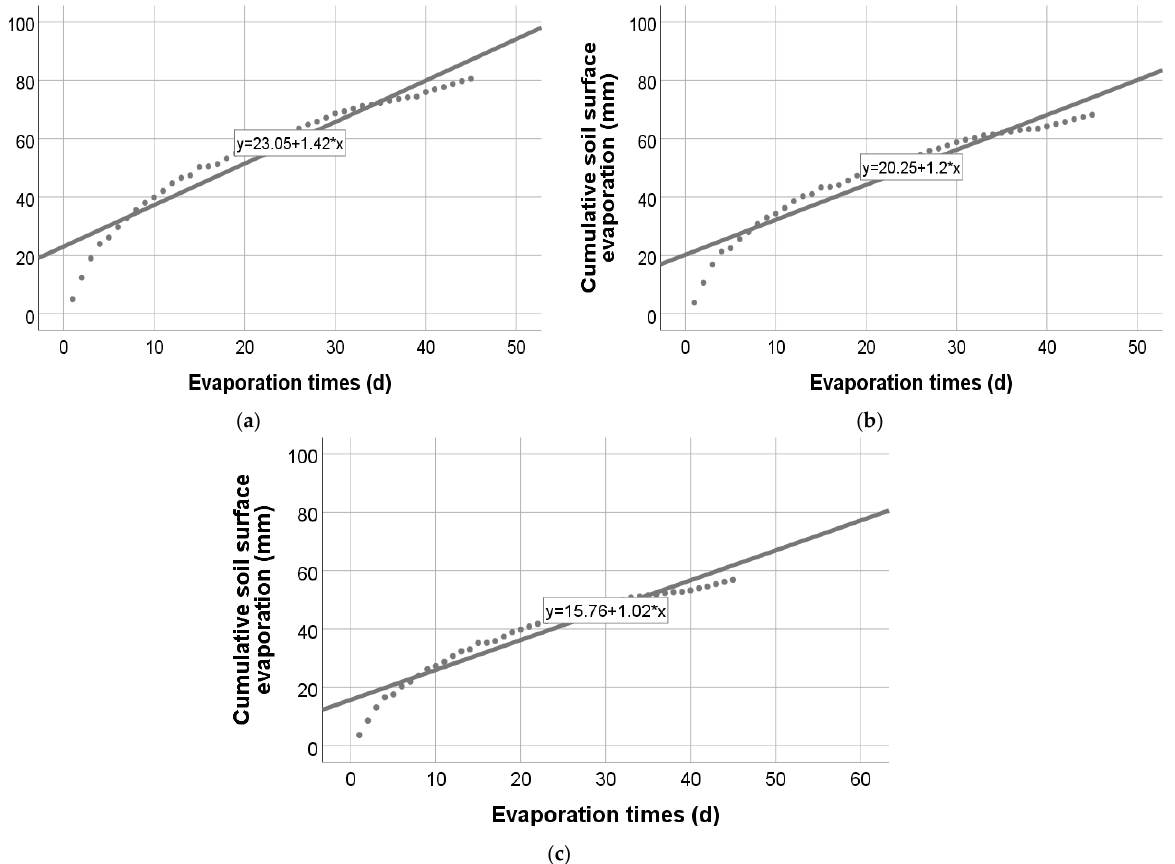
Figure 5. Cumulative soil surface evaporation and evaporation time under three treatments basis on the fitting equation in the ( a ) open-air, ( b ) under glass shed, and ( c ) a glass-shed covered with multilayer interference film.